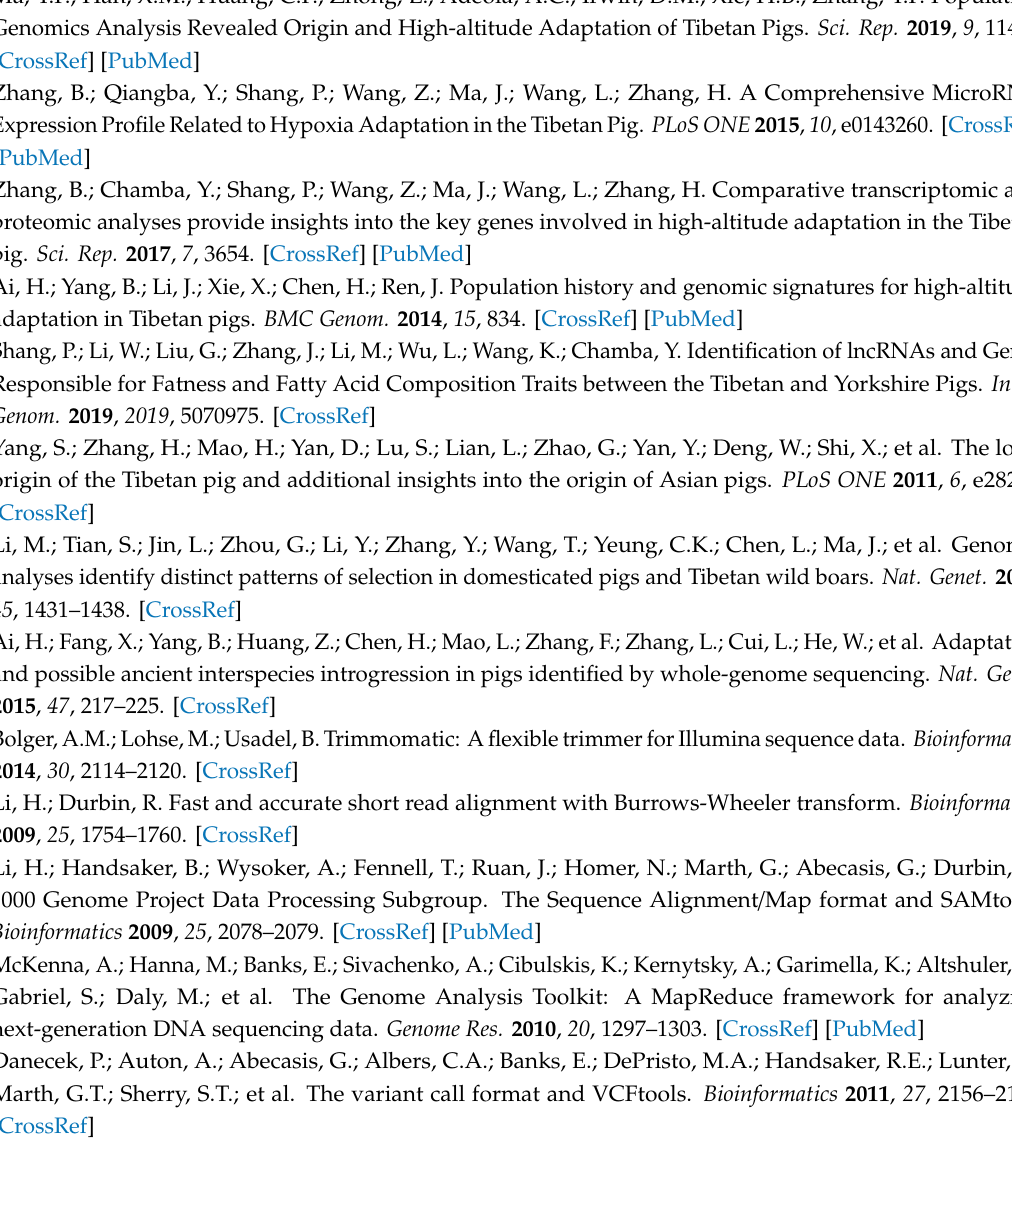
Table S1: Sample information of 10 Tibetan pig populations, Table S2: Annotation information and frequency distribution of deleterious variants of Tibetan pigs, Table S3: GO enrichment analysis of deleterious variants, Table S4: Gene list of selective regions, Table S5: GO enrichment analysis of genes under